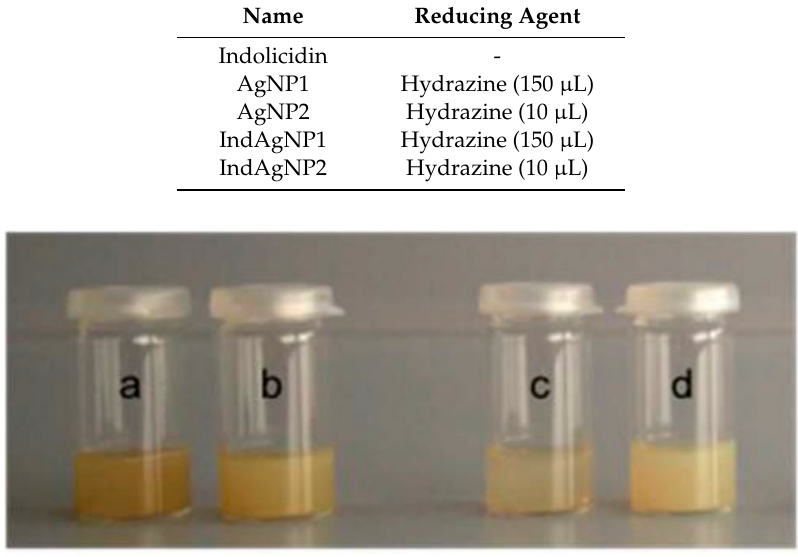
Figure 1. Silver colloids prepared using 150 μ L ( a , c ) and 10 μ L ( b , d ) hydrazine monohydrate in the presence of indolicidin ( a , b ) and without indolicidin ( c , d ).